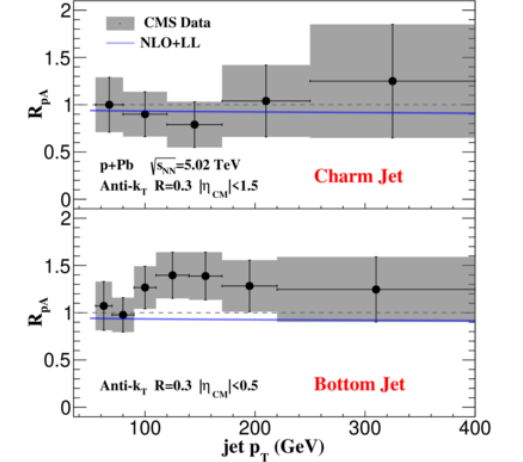
Figure 4 . Comparison of theoretical predictions for the heavy flavor jet cross sections in proton- nucleus collisions R to CMS measurements [4, 5] of c-jets (top) and b-jets (bottom). The system pA = 5 . 02 TeV and the jets are constructed using the anti-k algorithm with R = 0 . 3. is p+Pb at √ s NN T The rapidity cut in the center-of-mass frame is < 1 . 5 for c-jets and η CM < 0 . 5 for b-jets. η CM | | | | R pA for c-jet, displayed in the top panel, describes the CMS data [5] very well. In the bottom panel, the prediction is on the lower edge of the experimental error bar [4]